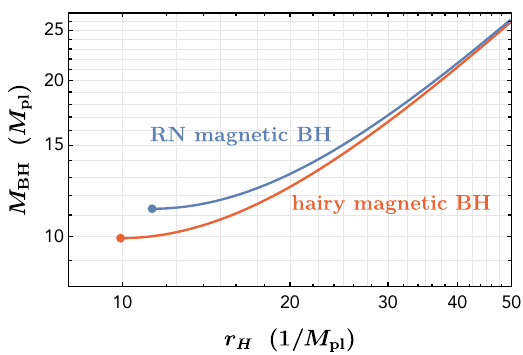
Figure 2 . The black hole masses as functions of horizon radii for both the hairy and RN magnetic black holes. The left endpoints of the two curves correspond to the extremal black hole